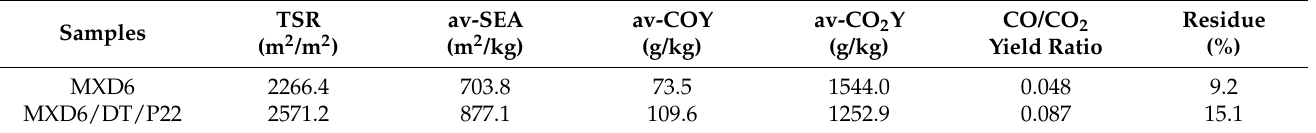
Table 5. Parameters during combustion of neat MXD6 and